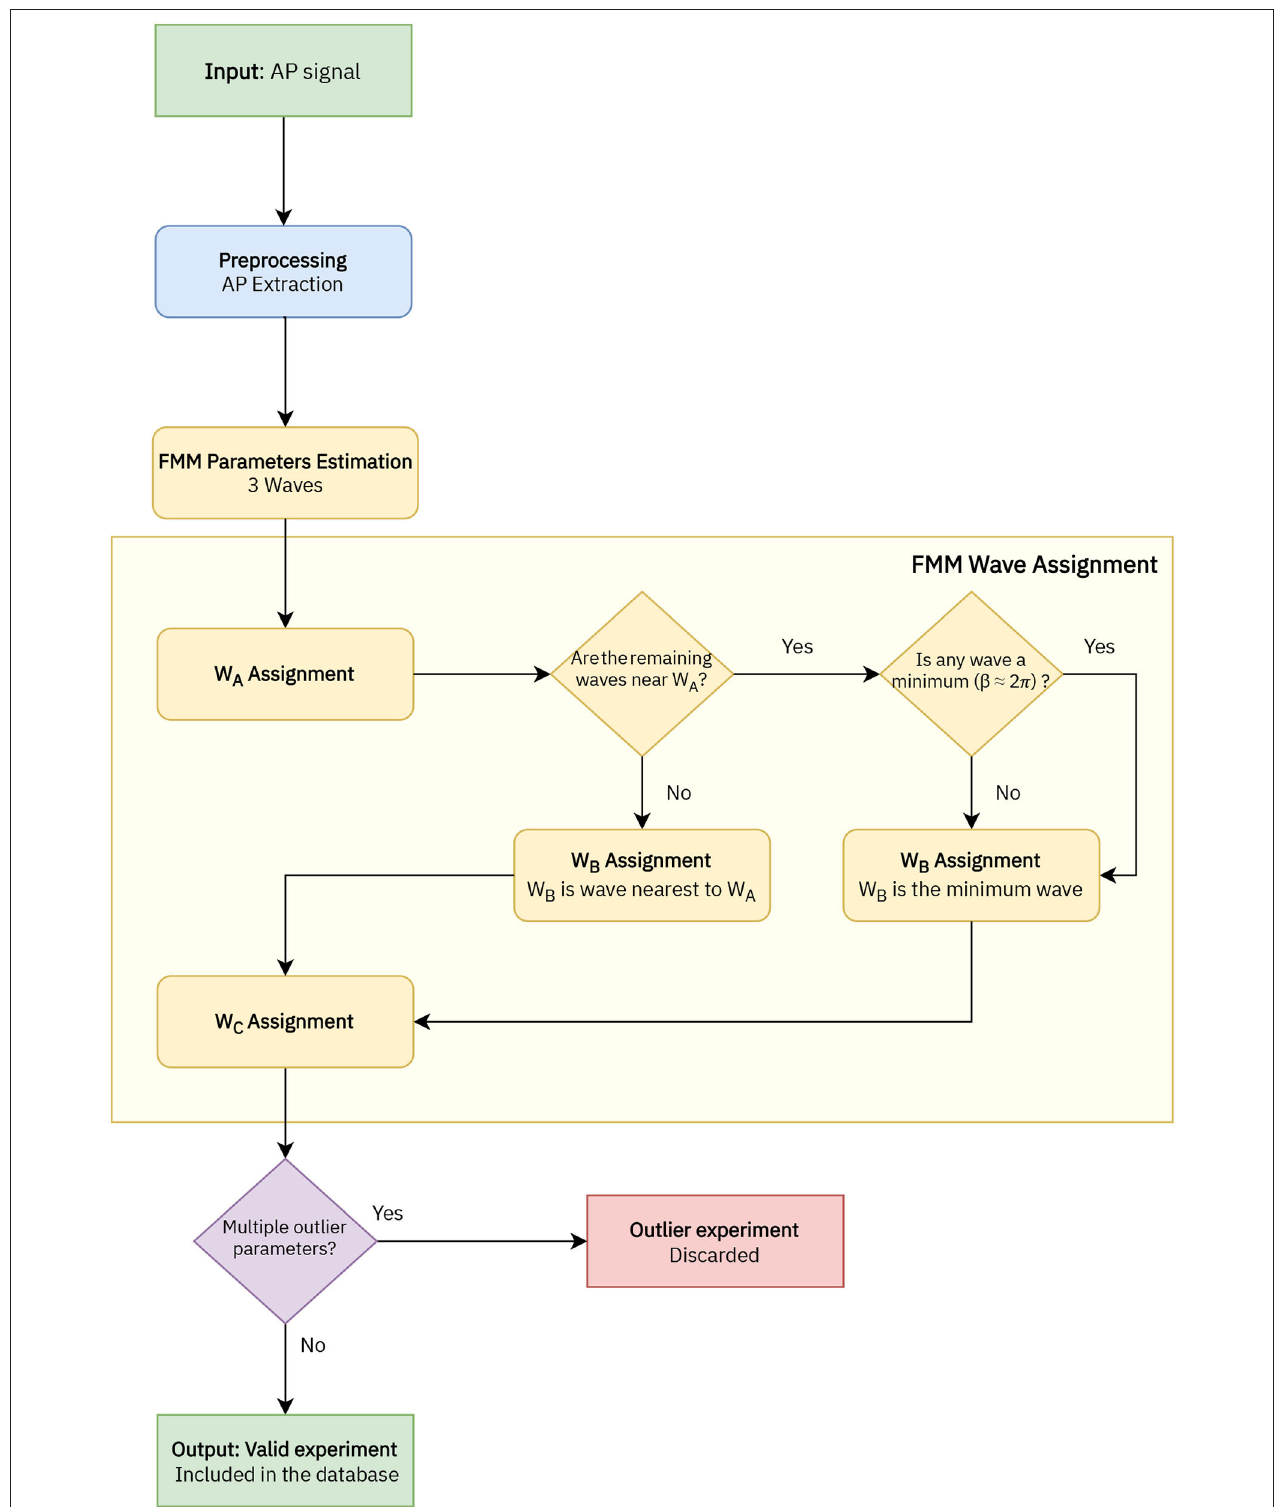
FIGURE 2 | Flowchart of the implemented algorithm to analyse the AP signals with the FMM model, which includes four stages: AP extraction, FMM parameters estimation, wave assignation, and outlier detection.